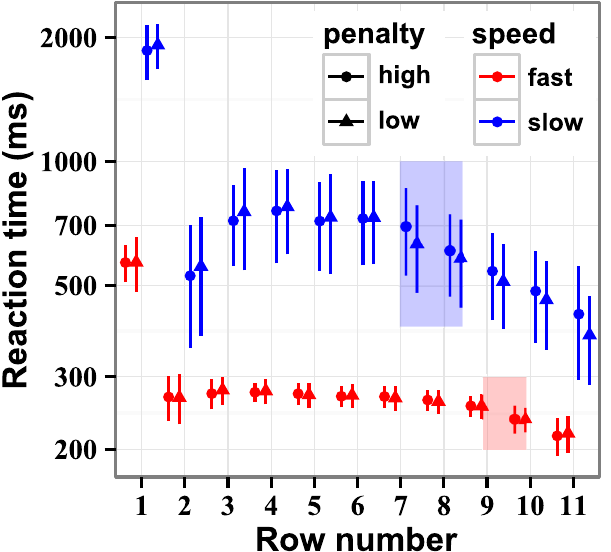
Fig 8. Reaction times averaged for all participants. The data are plotted separately for the speed and penalty conditions. The reaction times are markedly longer on the first stimulus row, just after the stimulus is revealed. Towards stimulus end, the reaction times drop off, reflecting the reduced amount of computation required for planning action over the reducing number of remaining rows. The shaded blue and red regions represent the rows on which the number of rows to stimulus end is equal to participant ’ s estimated depths of computation, where the approaching stimulus end is expected to have an effect on reaction times. Indeed, the reaction times start to drop at about the predicted rows. The data are averages of log reaction times (since the data were highly skewed) and the error bars are bootstrapped 95% confidence intervals.